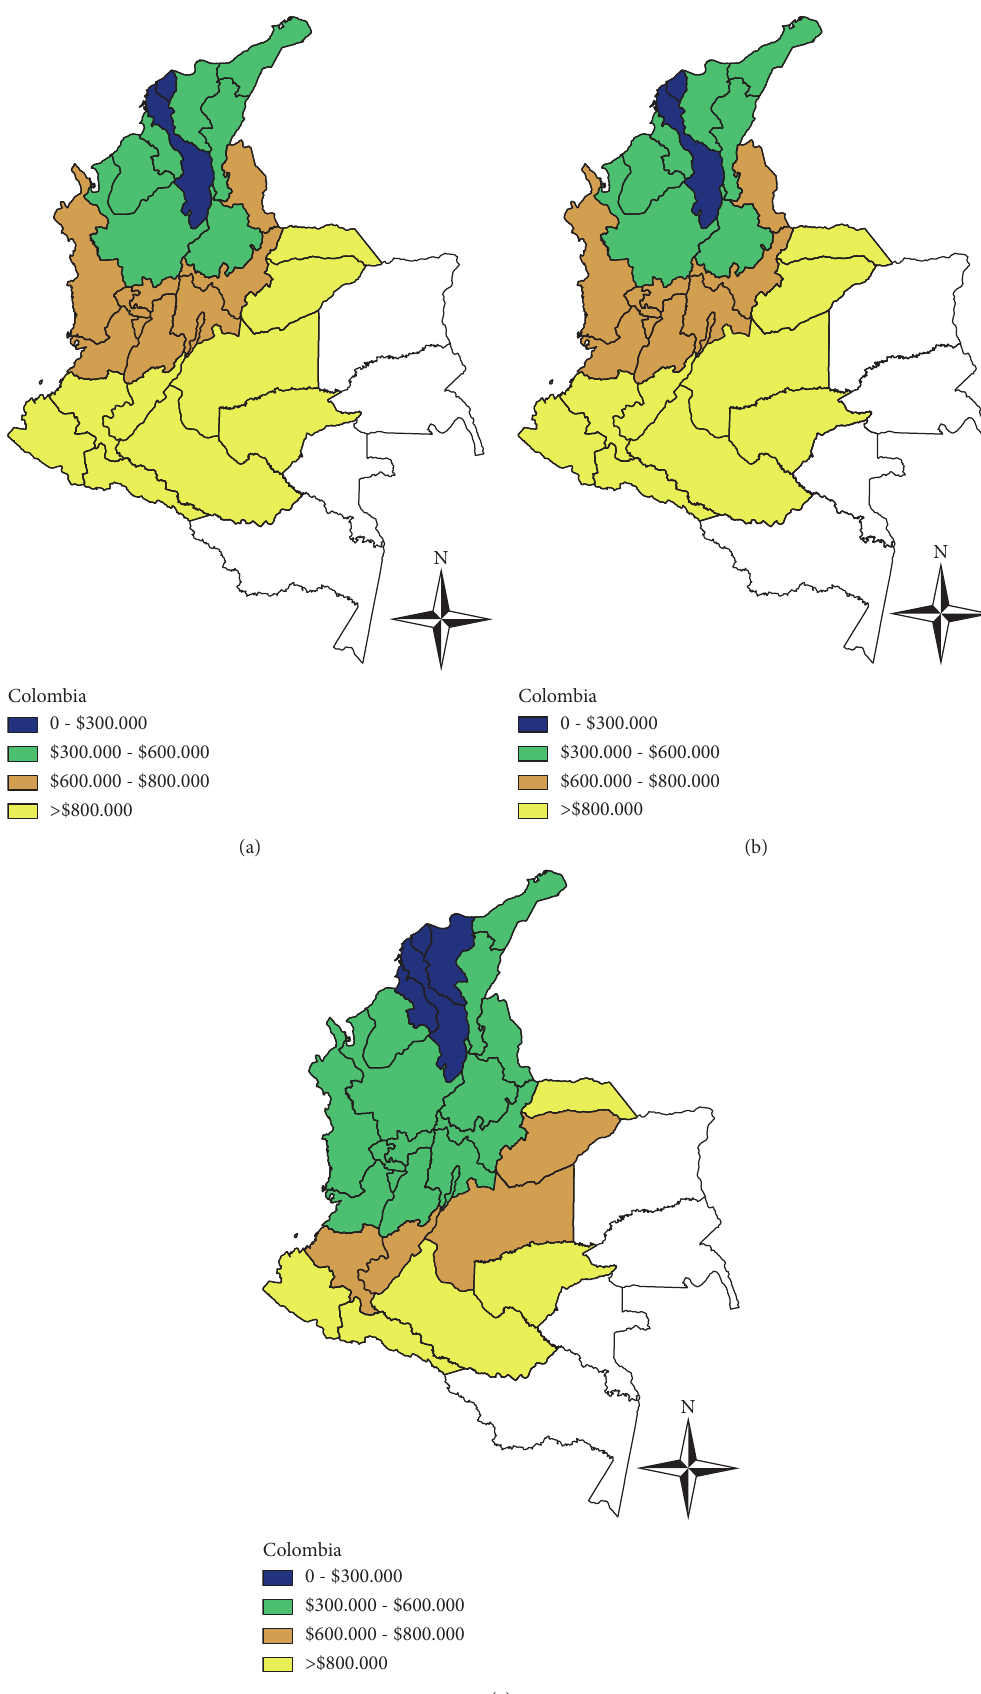
Figure 5: Spatial-based accessibility measure. (a) Spatial separation measure under Scenario 1, (b) spatial separation measure under Scenario 2, and (c) spatial separation measure under Scenario